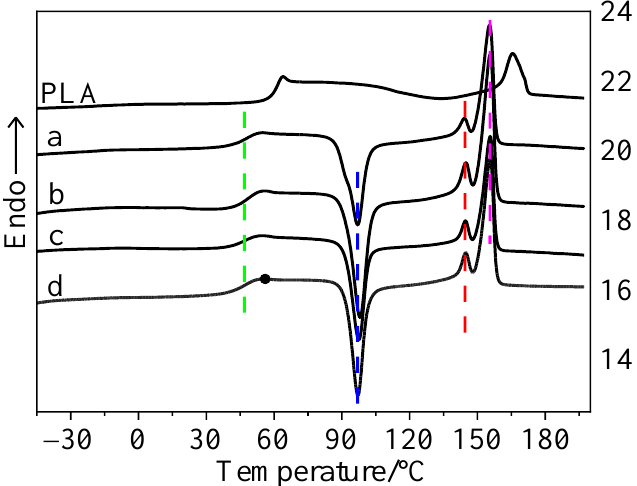
Figure 1. DSC curves of neat PLA and the PLA/thermoplastic starch/SiO 2 composite without a thermal history. Curve (a) is for two parts, (b) is for four parts, (c) is for six parts, and (d) is for eight parts of SiO 2 in thermoplastic starch.